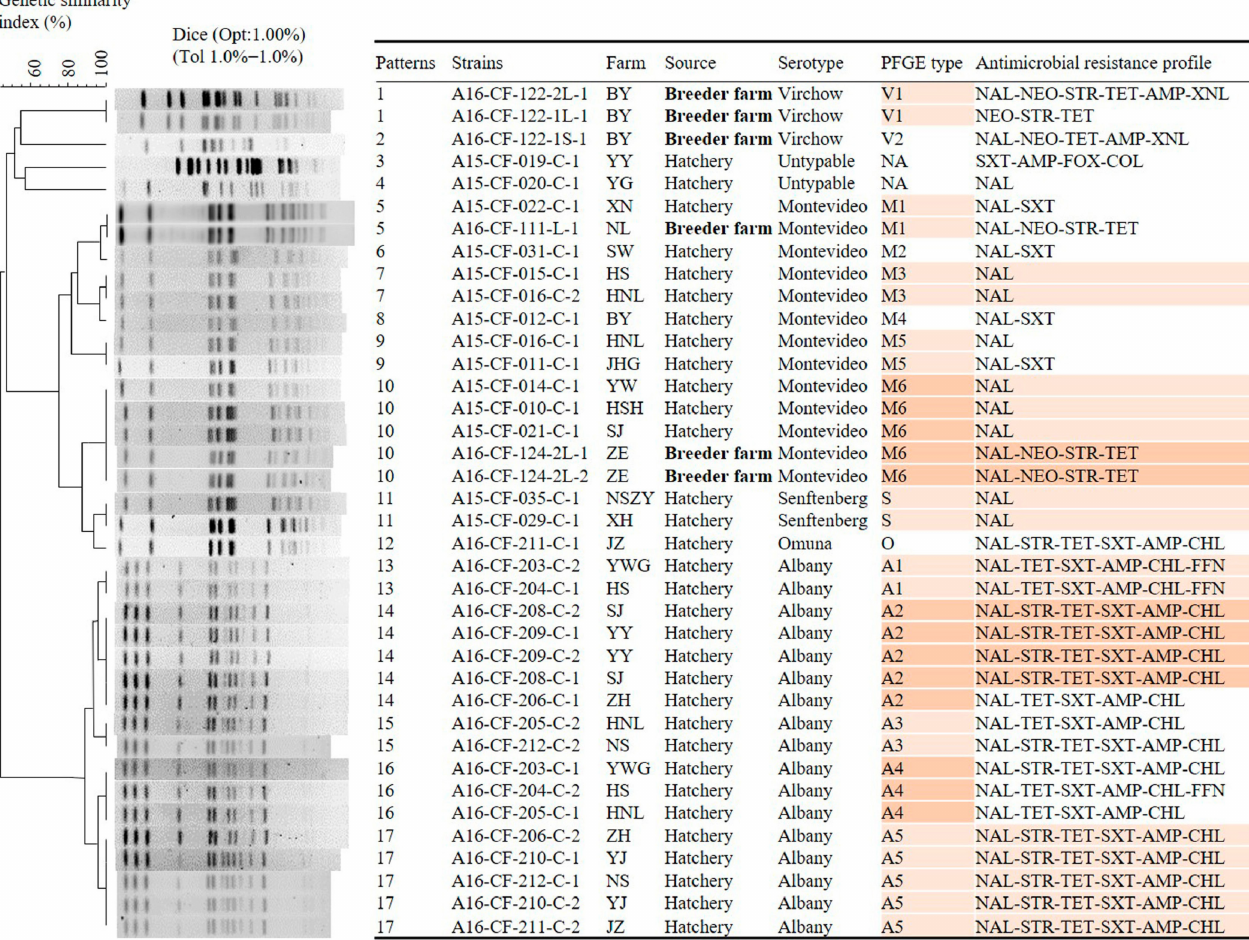
Figure 1. Dendrograms of the pulsed-field gel electrophoresis (PFGE) types of the 38 selected Salmonella isolates recovered from the hatchery and upstream breeder farms. These isolates and their association with source and antimicrobial resistance profiles are shown. Backgrounds with the same-colored bars (orange) indicate samples with the same PFGE patterns and antimicrobial resistance profiles; bold and non-bold indicate samples with different